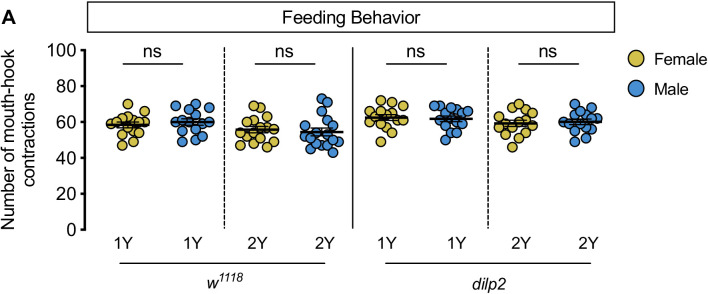
No sex difference in food intake in dilp2 mutant larvae.(A) There was no significant difference in mouth hook contractions between w1118 control male and female larvae raised on a diet containing a widely-used protein content (1Y) (p=0.5015; Student’s t test), or a protein-rich diet (2Y) (p=0.6514; Student’s t test). There was no significant difference in mouth hook contractions between dilp2 mutant male and female larvae raised in 1Y (p=0.7667; Student’s t test), or 2Y (p=0.7101; Student’s t test). n = 15–17 biological replicates. ns indicates not significant; error bars indicate SEM.